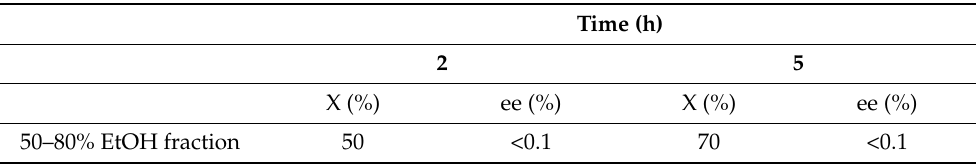
Table 6. Hydrolysis of IPG-octanoate using the 50–80% EtOH fraction in different reaction time points. X indicates conversion and ee indicates enantiomeric